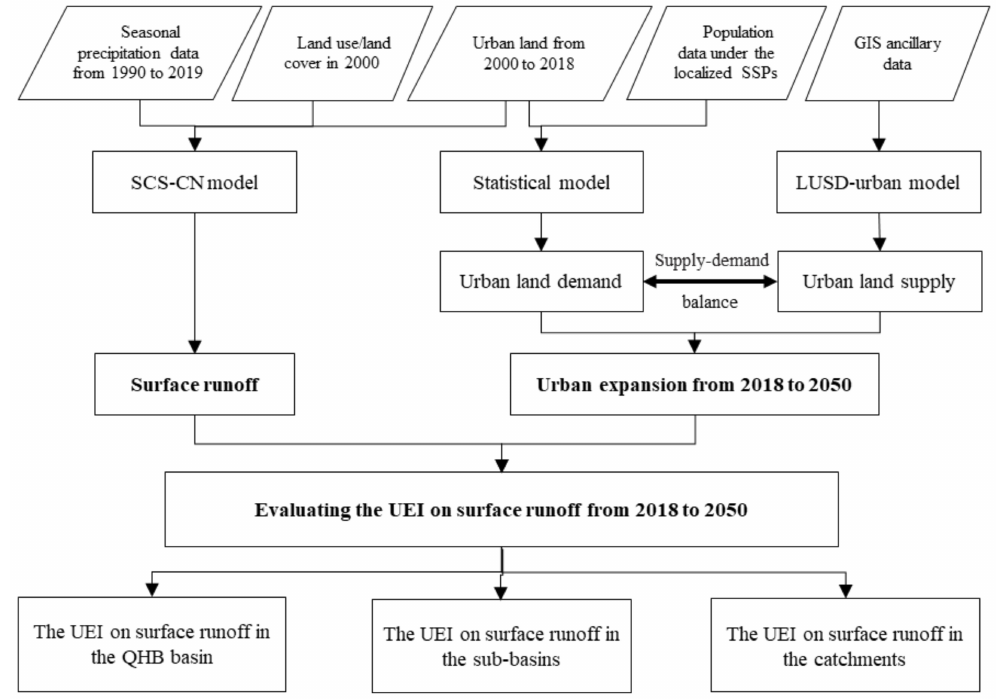
Figure 2. Flow chart. GIS: geographic information system; SCS-CN: conservation service-curve number; LUSD: land use scenario dynamics; UEI: urban expansion impacts; QHB: Qinghaihu-Huangshui